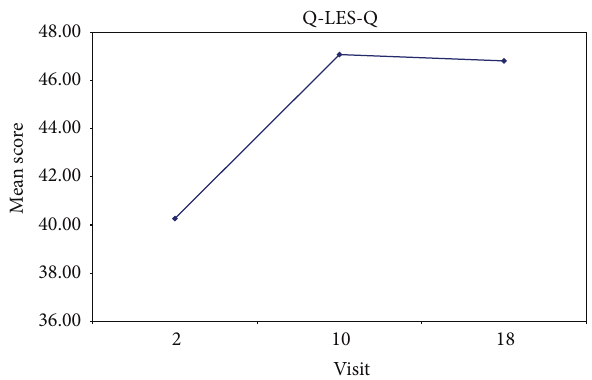
Figure5:ThisfigureillustrateschangesinQualityofLifeEnjoyment and Satisfaction Questionnaire scores over